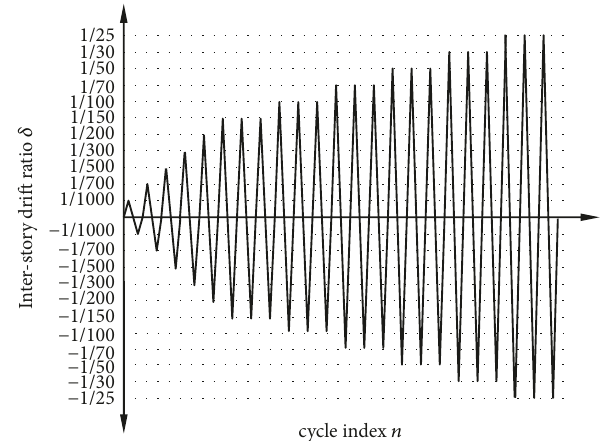
Figure 4: Loading history.